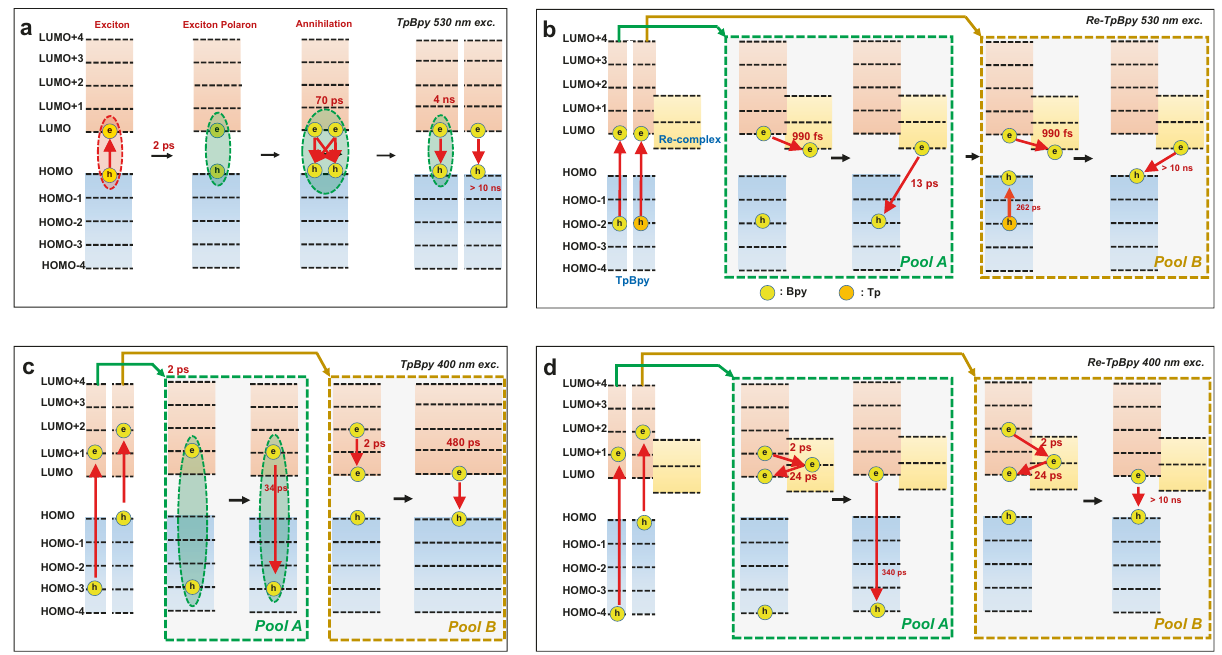
Fig. 8 Summary on the excited-state dynamics. Schematic diagram of the pathway and lifetime excited-state dynamics of TpBpy and Re-TpBpy under ( a ) ( b ) 530 nm, and ( c ), ( d ) 400 nm